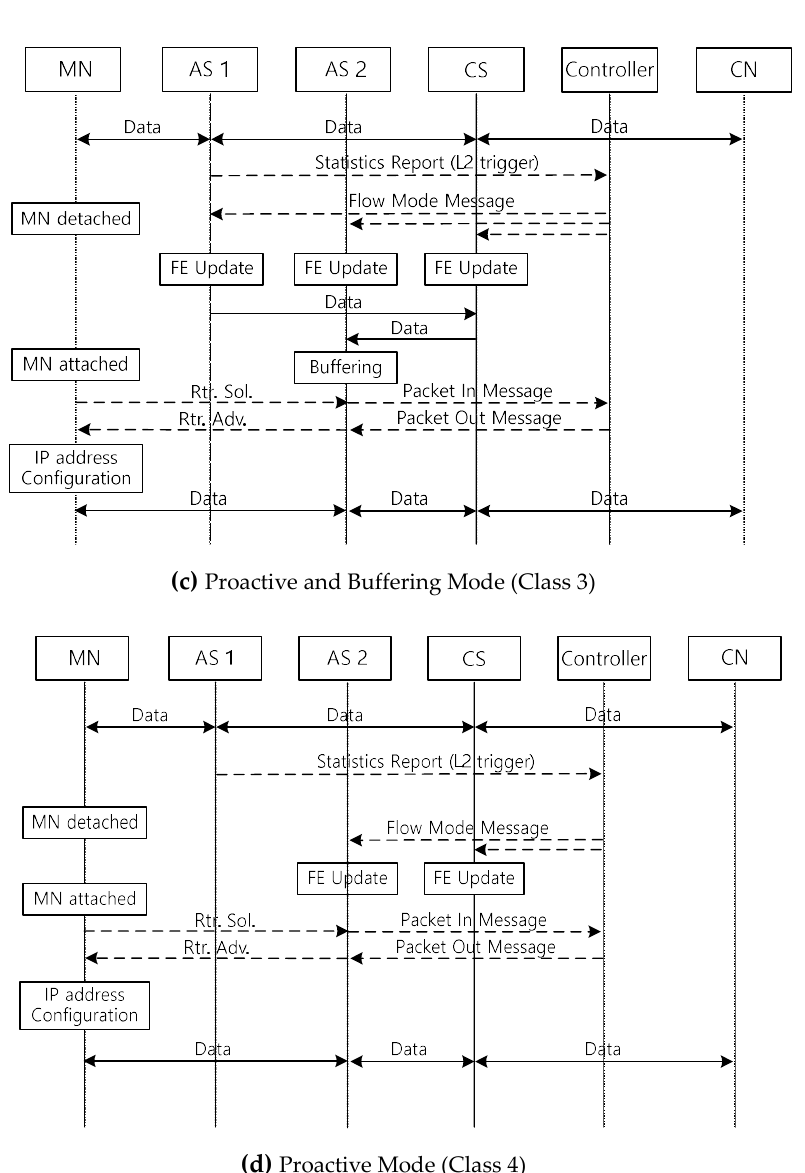
Figure 2. Quality of service (QoS)-based flexible handover procedures.